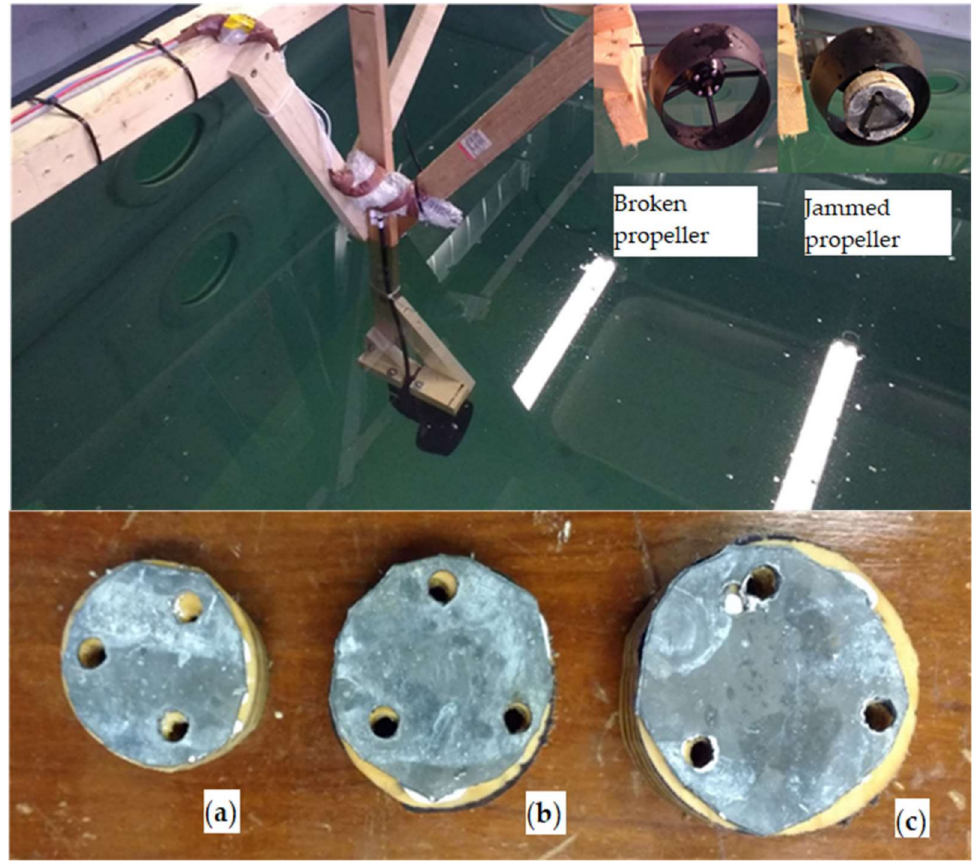
Figure 4. Thrustersetupforacquisitionofreal-worlddata: ( a )30%area“blockage”; ( b )60%area“blockage”; ( c ) 90% area